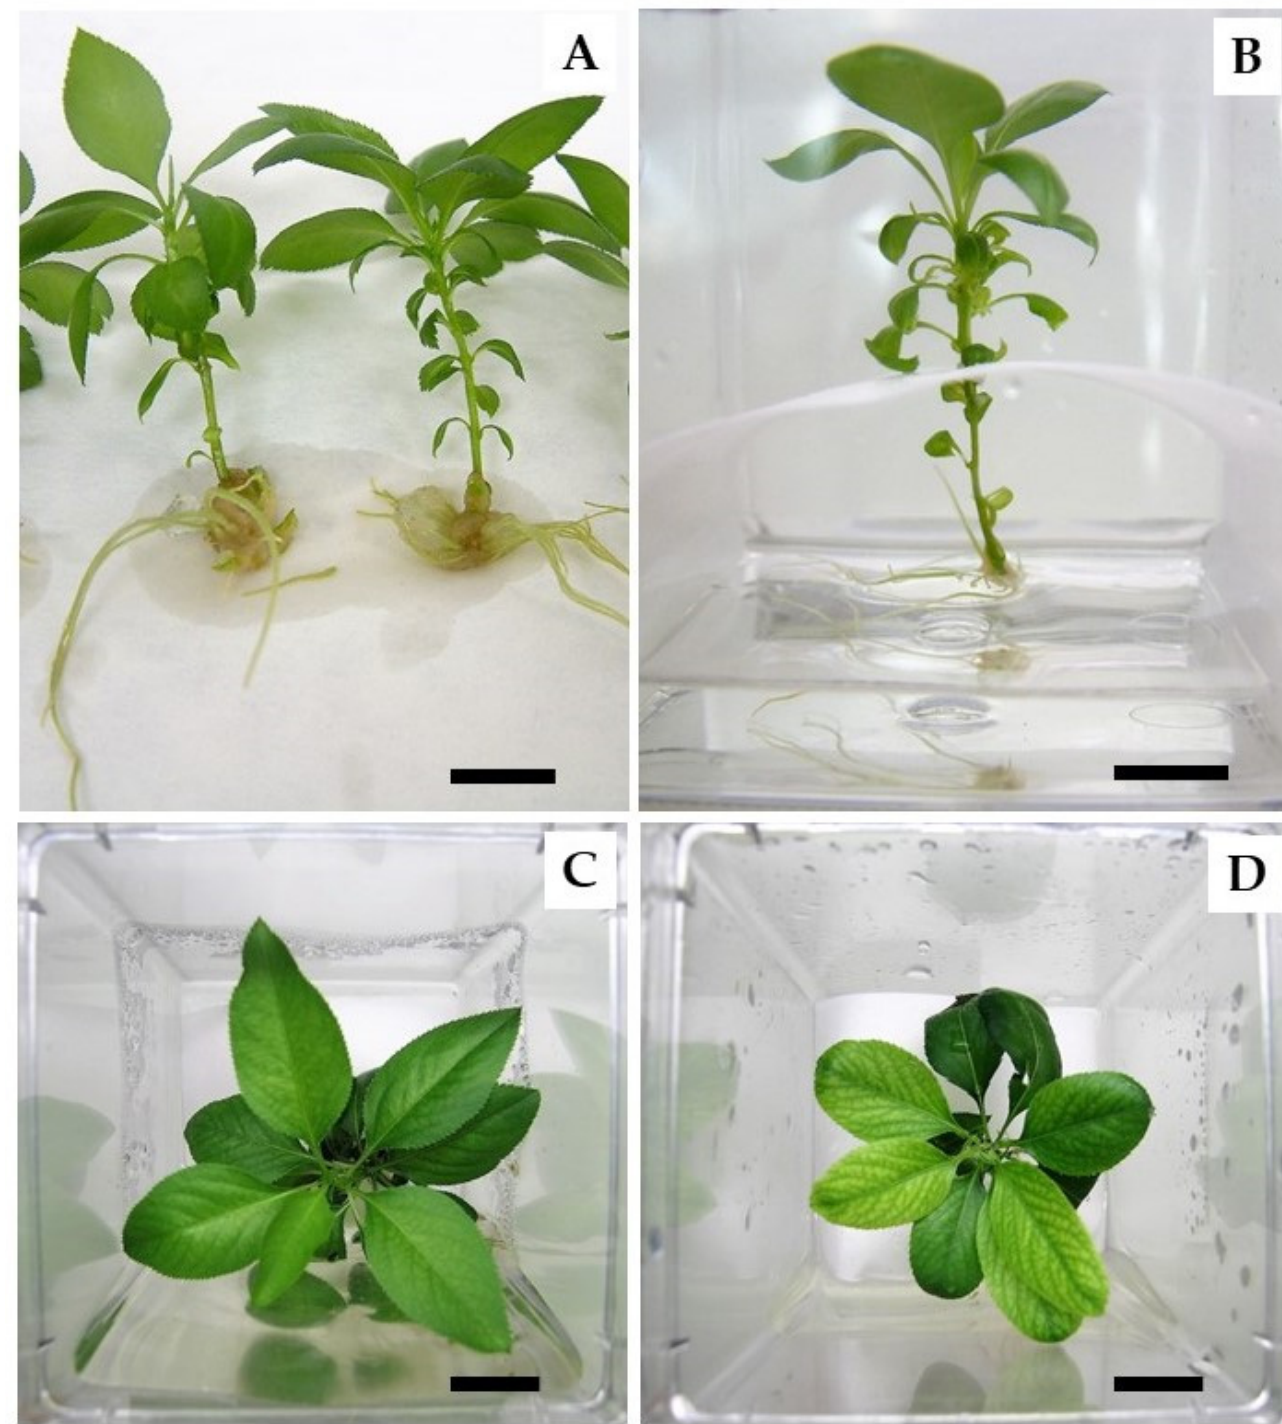
Figure 1. Rooted plant material used for the in vitro iron deficiency assay ( A ) in liquid cultures with a paper bridge ( B ) at day 0 of the assay, and after a 28-day-long culture under iron deficiency conditions in medium with 20 mM NaHCO 3 ( C , D ), showing high leaf chlorophyll levels in the case of ‘Pyriam’ x Pyrus communis spp cordata hybrid Pcc38 ( C ) or leaf chlorosis in the open pollinated P. communis ‘Williams’ Pcw12 ( D ). Bars are 1-cm-long.